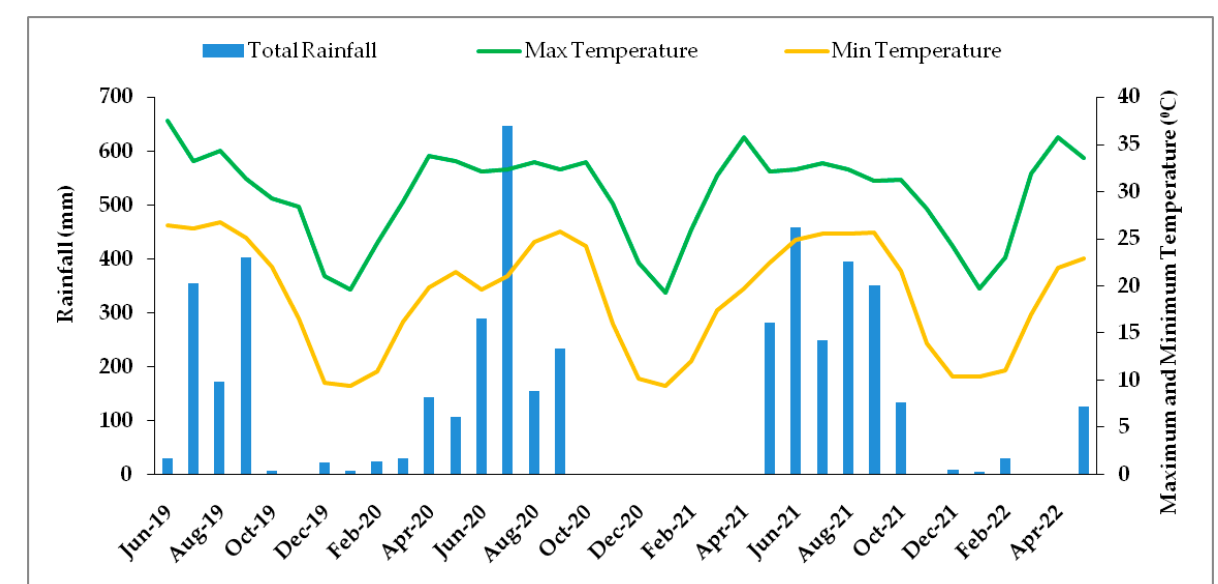
Figure 1. Monthly rainfall, mean monthly maximum and minimum temperature during the years of experimentation during